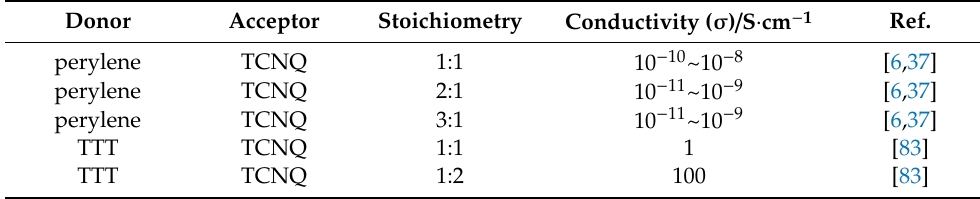
Table 3. The conductivity of some CTCs with di ff erent